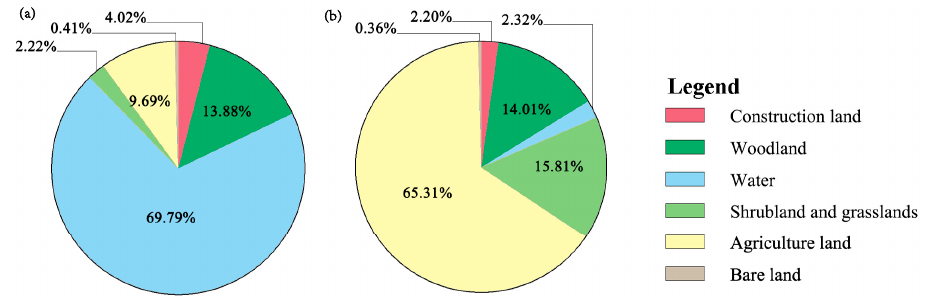
Figure 13. Comparison of land-use types in areas of changed ecological space: ( a ) Shrinking area; ( b ) Expansion